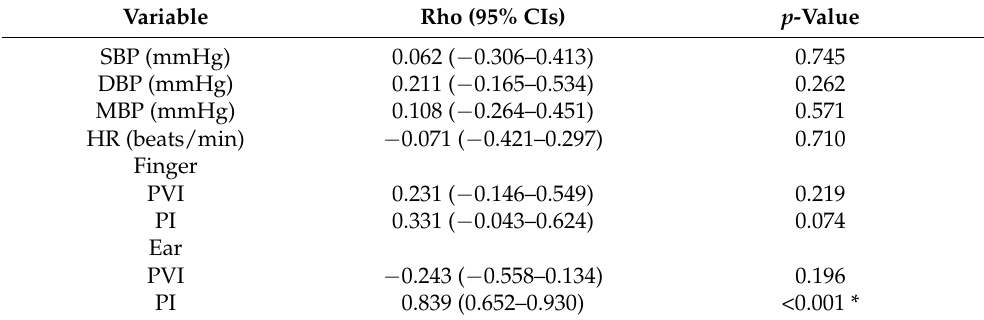
Table 3. Correlation between the lowest SBP and hemodynamic variables measured at baseline.